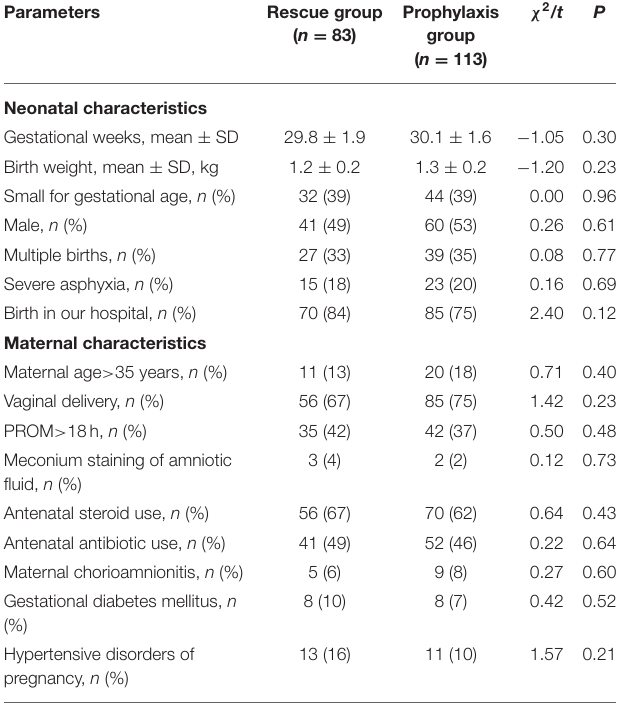
TABLE 1 | Comparison of infant baseline characteristics between two